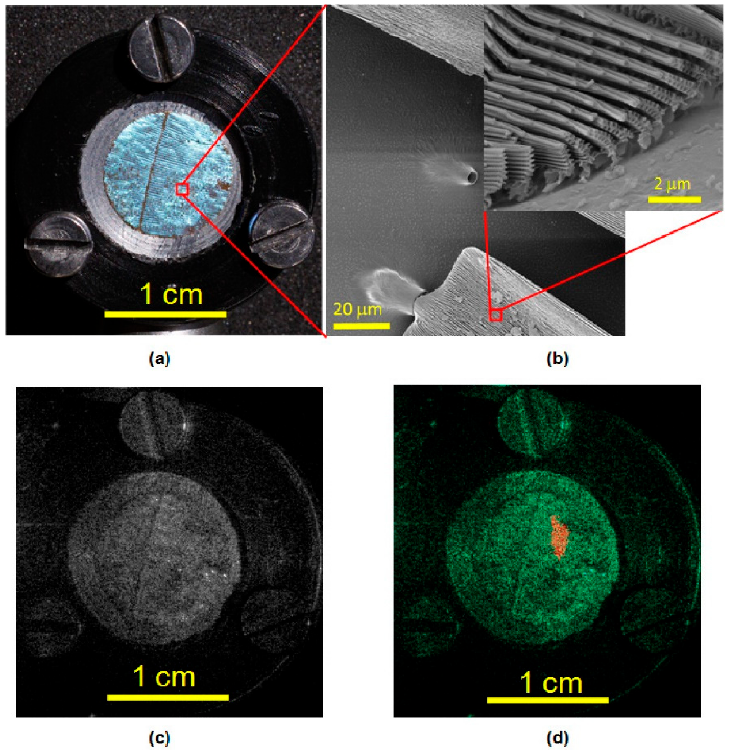
Figure 5. Circular section of a butterfly’s wing: ( a ) A photograph, ( b ) a microscope image, ( c ) a hologram reconstruction and ( d ) a holographic image. Reproduced with permission [40].